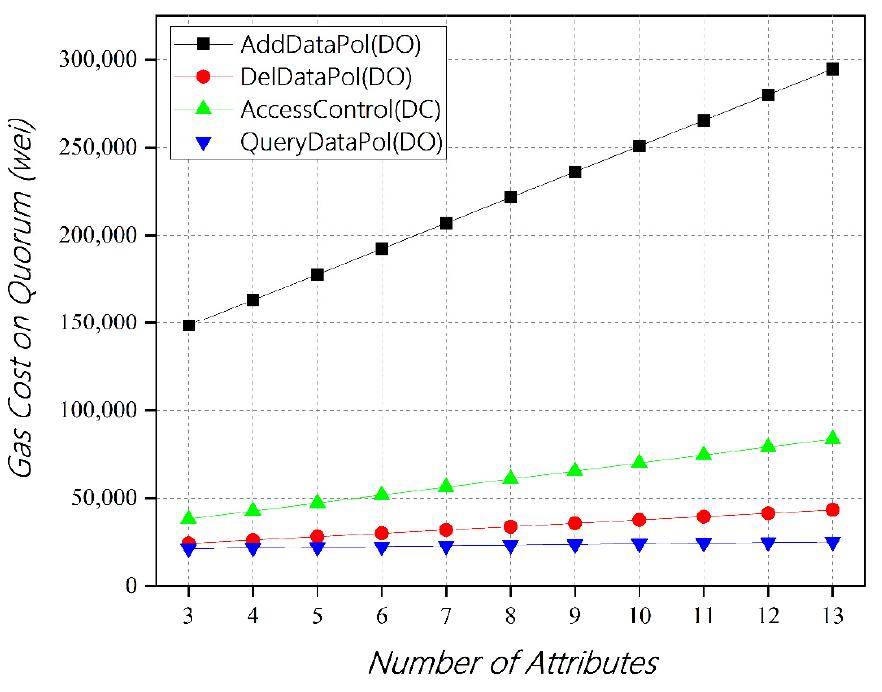
Figure 9. The variation in gas costs of AddDataPol , DelDataPol , AccessControl , and QueryDataPol